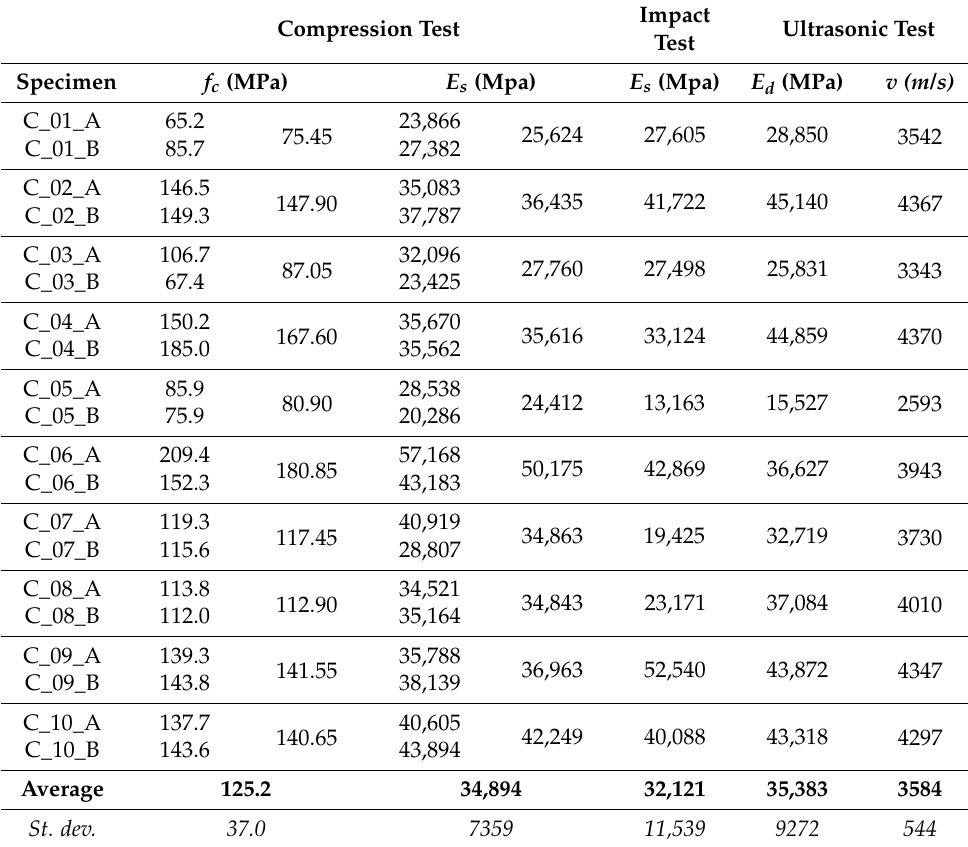
Table 1. Results of laboratory tests correlated to non-destructive